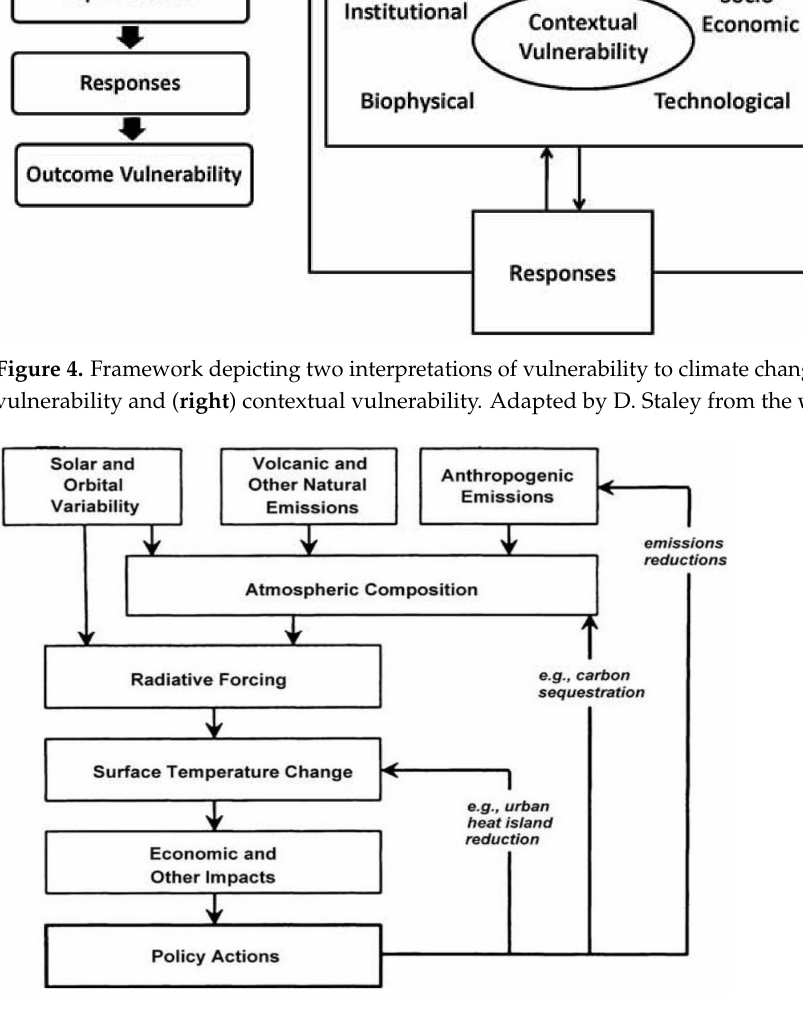
Figure 5. Conceptual framework showing how radiative forcing fits into the climate policy framework from